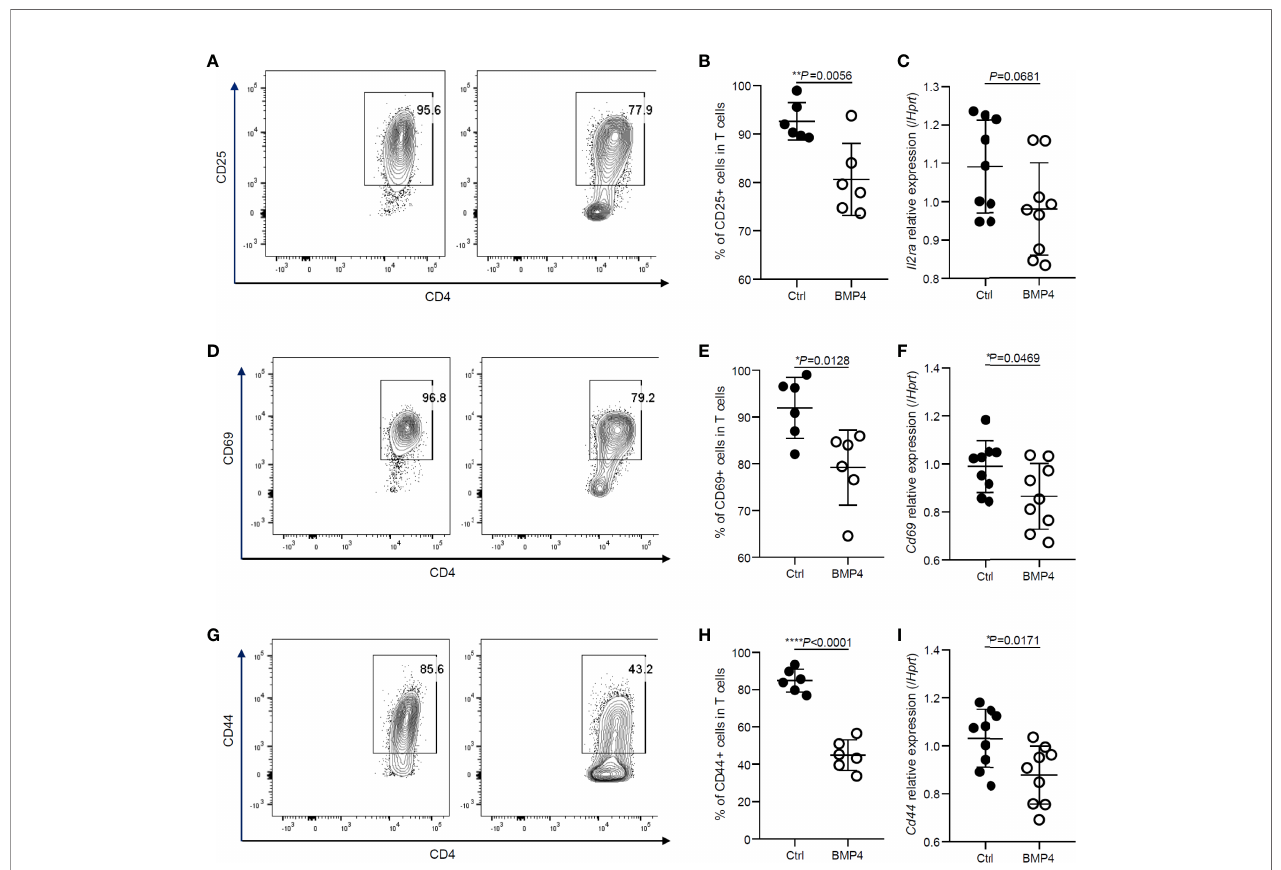
FIGURE 1 | BMP4 downregulates the activation of naïve CD4+ T cells. (A) The expression of CD25 on T cells tested by fl ow cytometer 24 hours after TCR activation with or without BMP4 treatment. (B) The frequency of CD25+ T cells. (C) The gene expression of Il2ra checked by Quantitative real-time PCR. (D) The expression of CD69 on T cells. (E) The frequency of CD69+ T cells. (F) The gene expression of Cd69 checked by Quantitative real-time PCR. (G) The expression of CD44 on T cells. (H) The frequency of CD44+ T cells. (I) The gene expression of Cd44 checked by Quantitative real-time